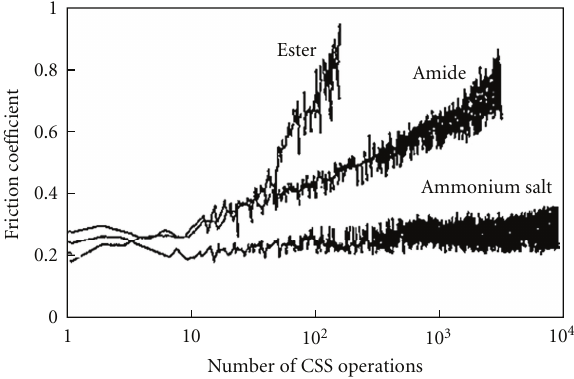
Figure 7: Friction coe ffi cient of disk coated with ester lubricant (Lubricant 1), amide (Lubricant 3), and carboxylic acid ammonium salt (Lubricant 5) versus number of CSS operations.